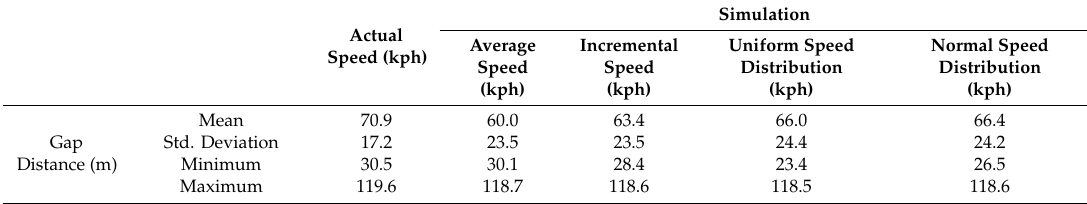
Table 2. Descriptive statistics for the gap distance acquired from actual data and simulation results. Actual